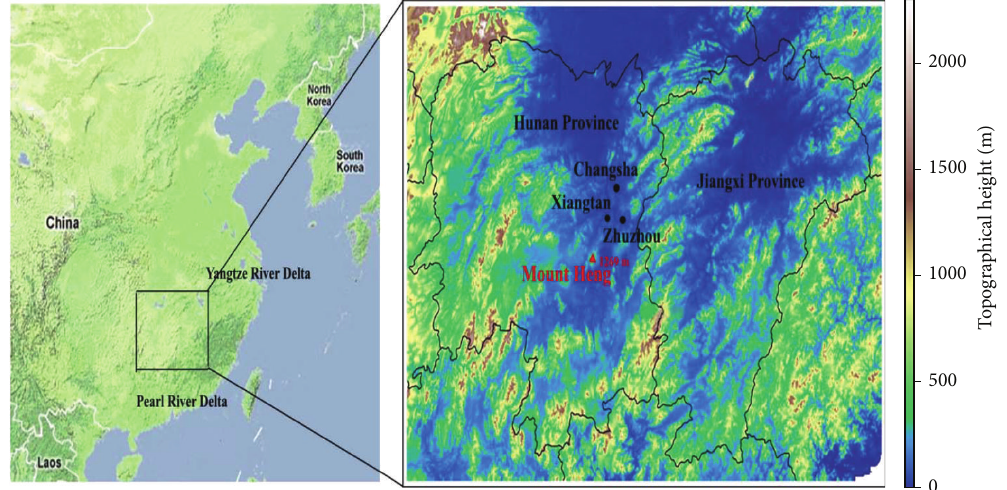
Figure 1: Geographical location of Mount Heng (cited from